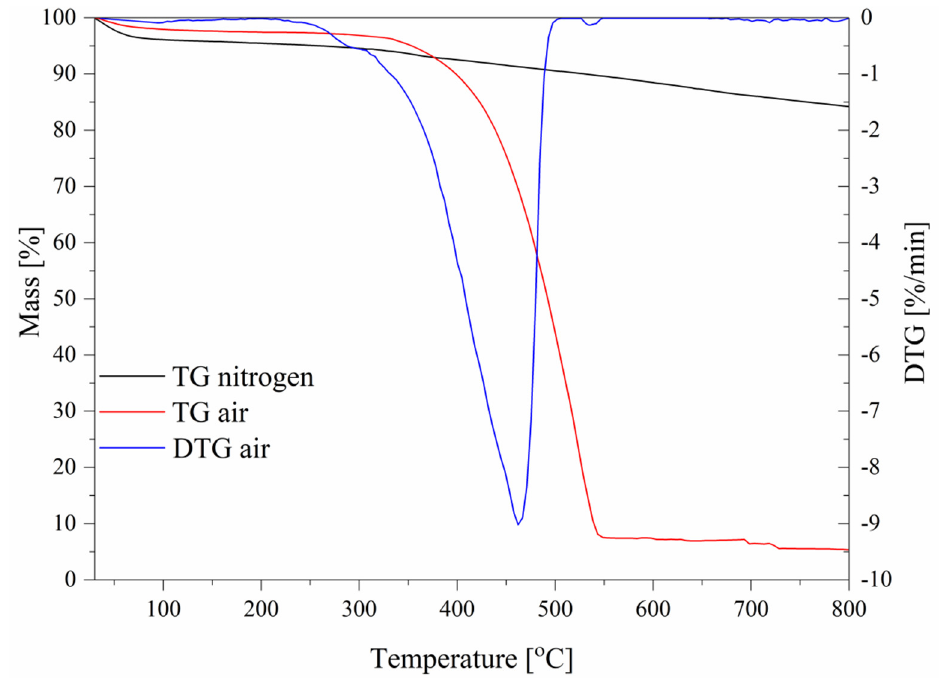
Figure 7. Thermogravimetric (TG) and derivative thermogravimetric (DTG) curves biocarbon under nitrogen and air atmosphere.